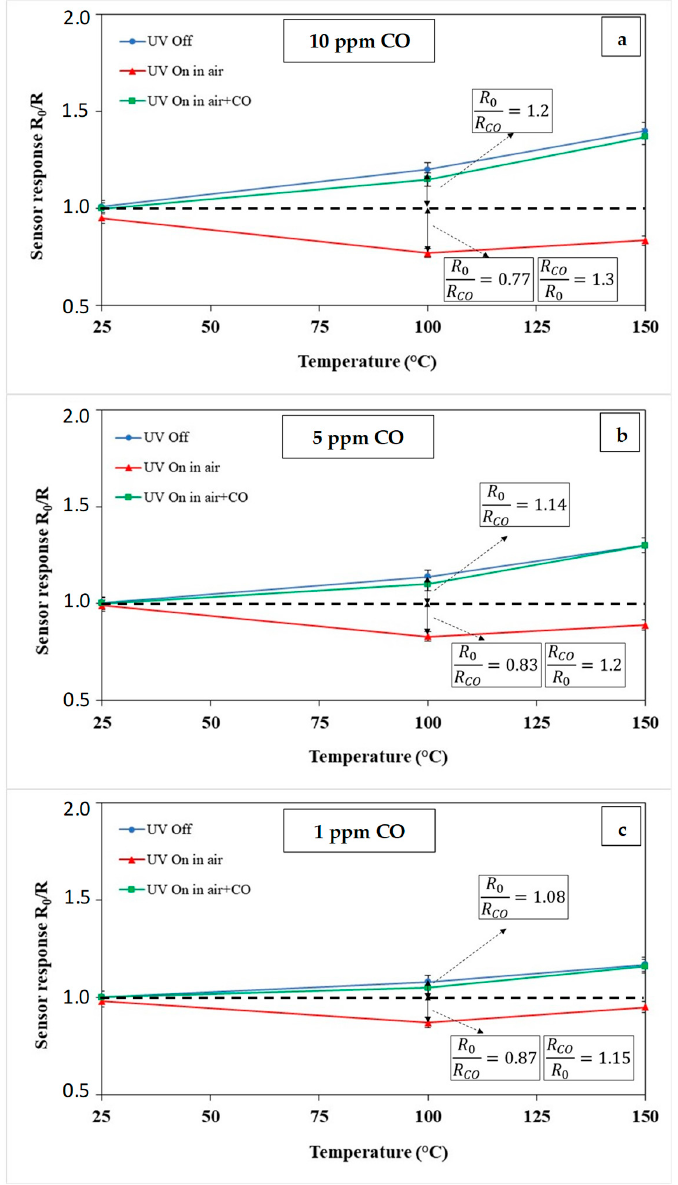
Figure 8. Sensor response to ( a ) 10 ppm; ( b ) 5 ppm and ( c ) 1 ppm of CO at different operating temperatures and different UV irradiation modes. Error bars are calculated on the average of five runs.